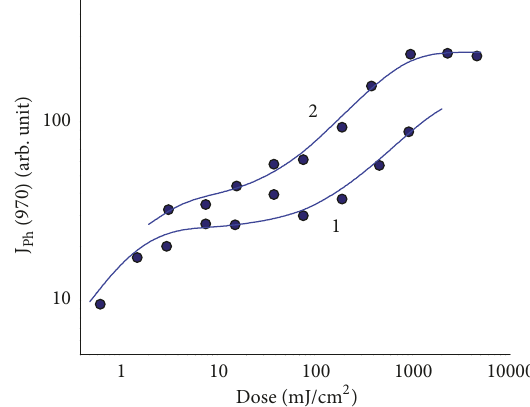
Figure 8: Dose dependencies of the phosphorescence intensity 𝐽 Ph of the ZnSe sample (for 30 s upon terminating excitation) at the registration within 970 nm band at the temperature of 85 K under = 5 mA (1) and 25 different intensities of the X-ray radiation: 𝑖 X - tube mA (2) . The solid lines show the theoretical dependency